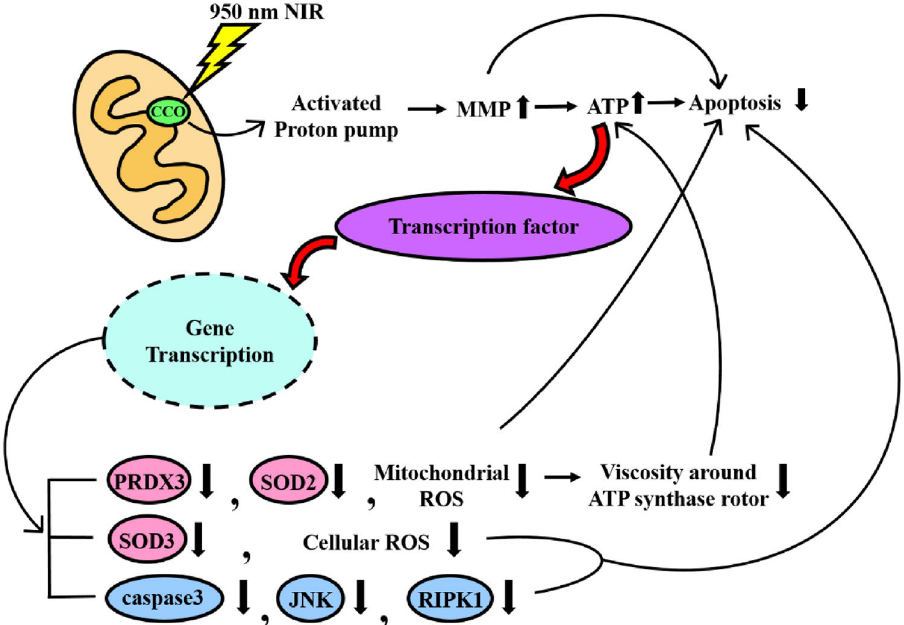
Figure 7. Schematic diagram of the mechanism of PBM in solving post-thawing trauma. The green color inside the mitochondria is a CCO that is activated during 950 nm NIR irradiation. The cyan circle is a nucleus in which ATP acts as a transcription factor to regulate mRNA expression. Red is ROS scavenger-related mRNA and blue is apoptosis-related